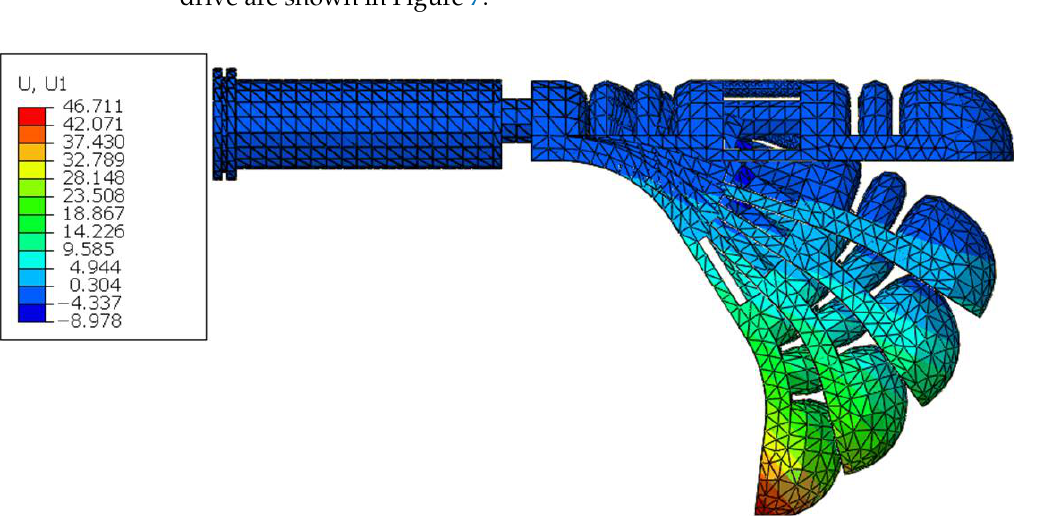
Figure 7. Curved shape of interphalangeal joint drive